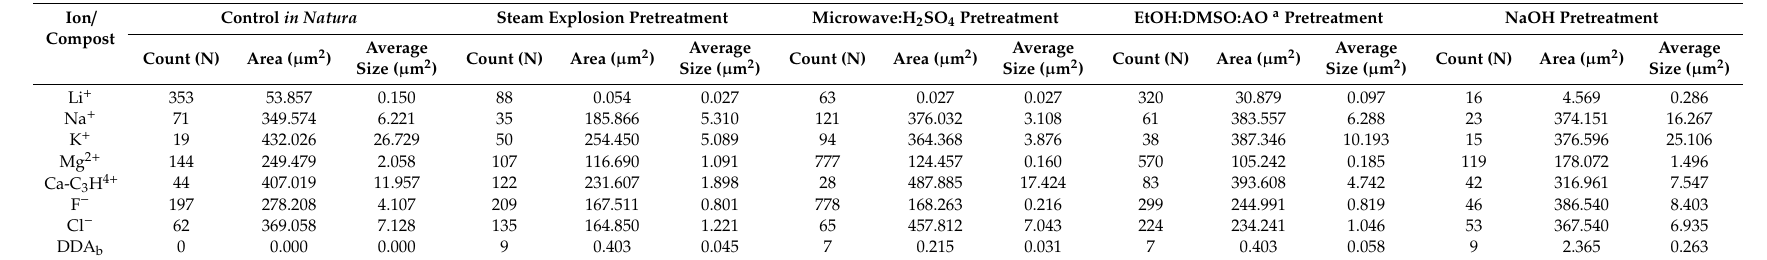
Table 1. Ion particle analysis after automated color threshold.